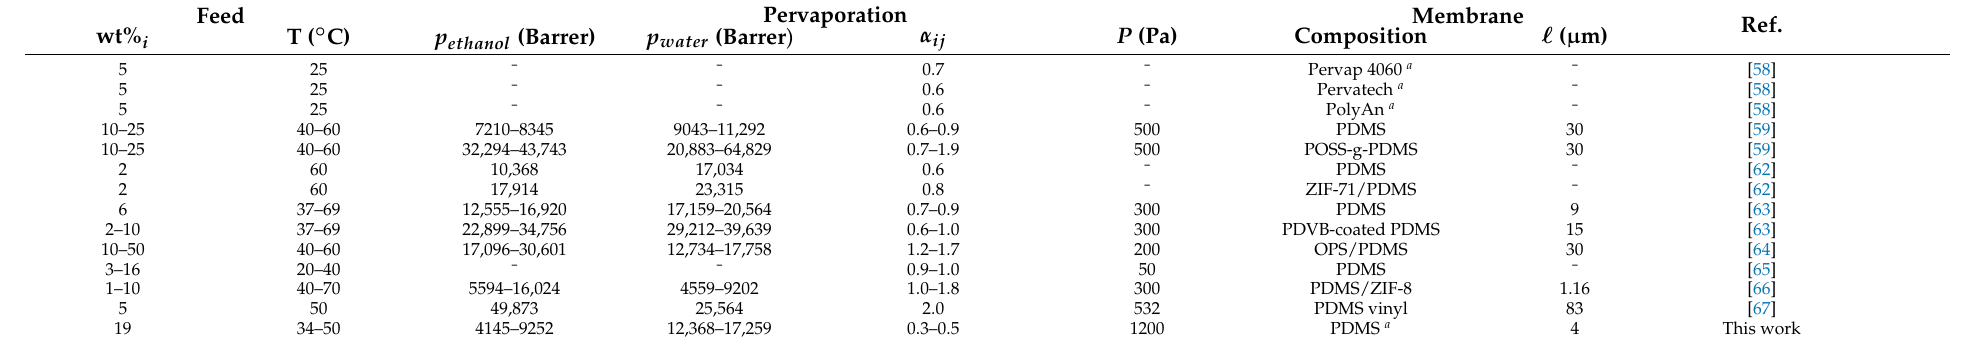
Table 2. Comparison of various PDMS membrane performances in the ethanol–water mixture